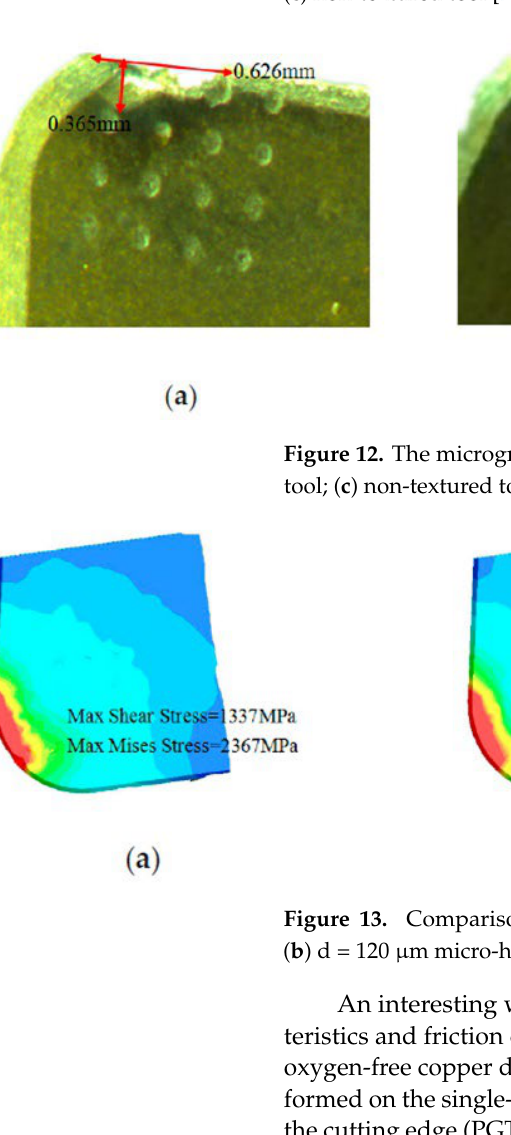
Figure 11. Predicted tool wear: ( a ) d = 80 µ m micro-hole tool; ( b ) d = 120 µ m micro-hole tool; ( c ) non-textured tool [78].